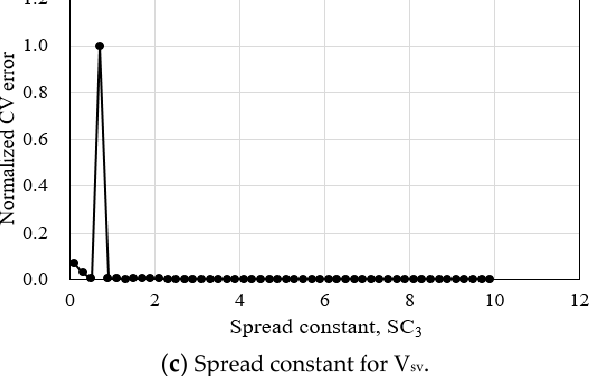
( c ) Spread constant for V sv .